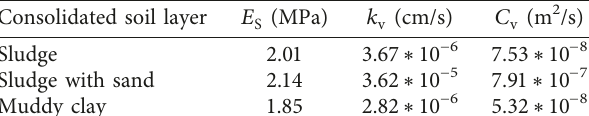
Figure 5: Ground settlement process from vacuum-surcharge preloading to stable settlement. Table 3: Initial compression modulus and permeability parameters of the soil layers.